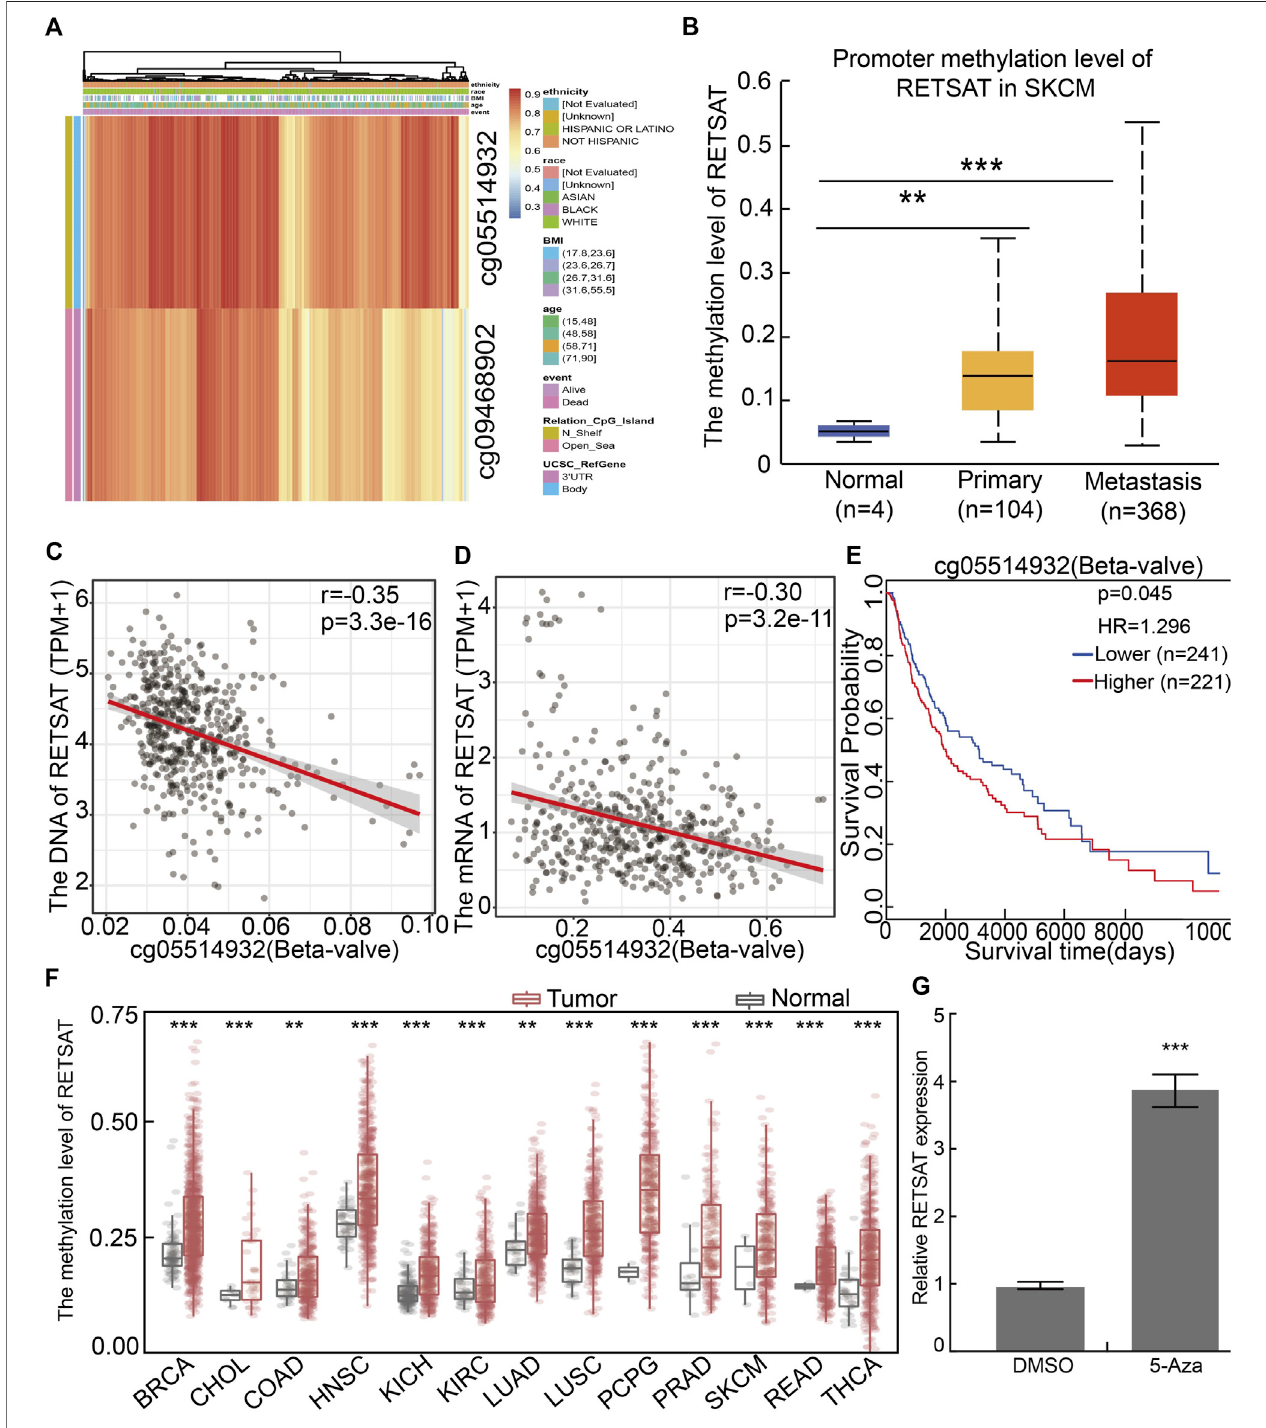
FIGURE2| ThemethylationpatterninRETSATpromoter. (A) CriticalmethylationsiteswithinRETSATpromoterregionwereindicatedintheheatmap.Thegradient color bars indicate the different methylation levels of the two methylation sites (cg05514932, cg09468902) within RETSAT promoter region in each SKCM sample, the browner the color is, the higher methylation level is. (B) The methylation level in RETSAT promoter region positively correlates with SKCM stages in ualcan database. (C,D) BoththeDNA (C) andmRNA (D) expressions ofRETSATnegatively correlatewiththemethylationlevelusingSMARTdatabase. (E) Kaplan-Meier analysisof OS (overall survival) considering RETSAT methylation level using the TCGA SKCM dataset. (F) The methylation level of RETSAT in different types of human cancers compared with that in normal tissues using SMART database. (G) The relative expression of RETSAT mRNA in B16 cells after 5-azacytidine treatment, examine by Real time RT-PCR assay. * p < 0.05, ** p < 0.01, *** p < 0.001.